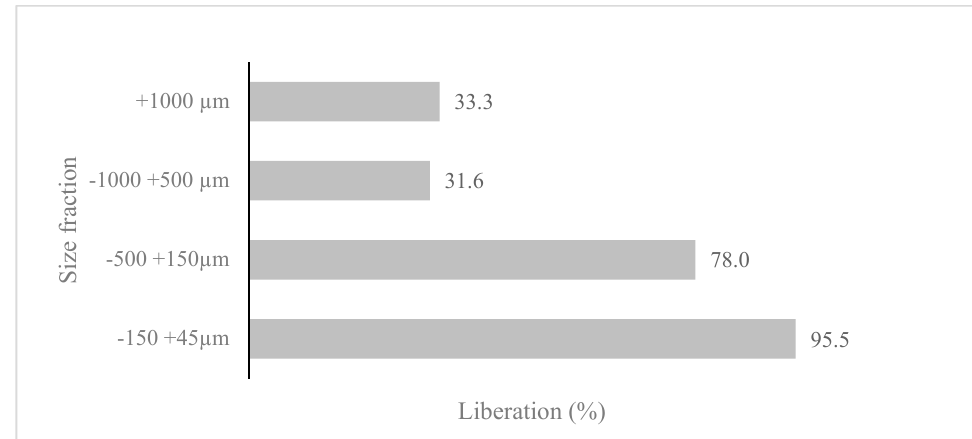
Figure 7. Quartz liberation in regard to the iron minerals of amphibolitic itabirite.